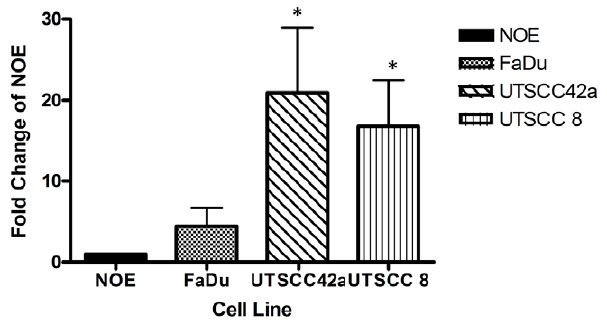
Figure 1. miR-193b is over expressed in HNSCC. (A) qRT-PCR analysis of miR-193b expression in FaDu, UTSCC 42a and UTSCC 8 compared with the NOE cell line. *P , 0.05.